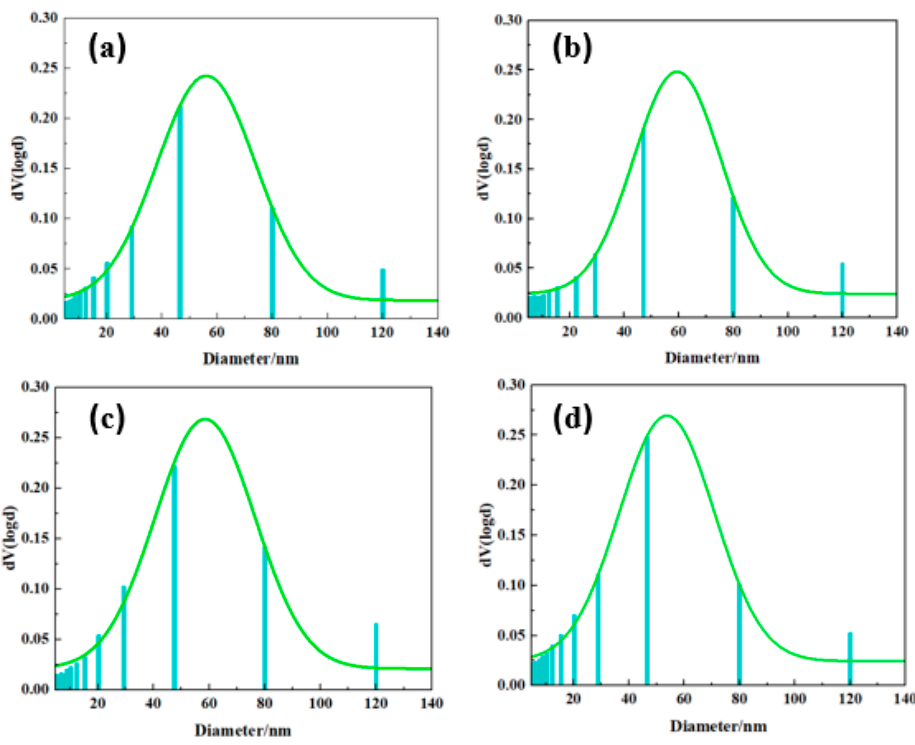
Figure 5. Pore distributions of different aerogels: ( a ) PBa; ( b ) PBa/DQ-1%; ( c ) PBa/DQ-3%; ( d ) PBa/DQ-5%.